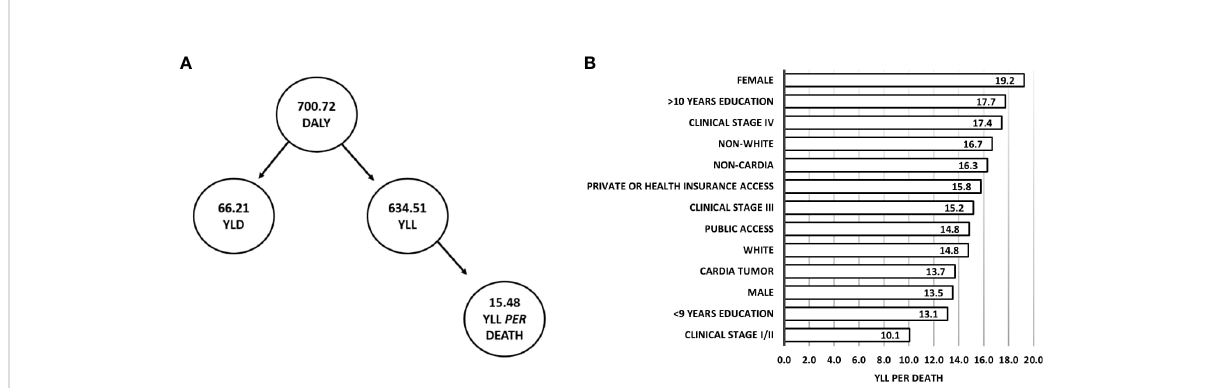
FIGURE 4 DALY (YLD plus YLL) and YLL per death at 1-year follow-up of Gastric Adenocarcinoma. (A) Flowchart of DALY composition and average YLL per death. (B) YLL per death according to clinical and sociodemographic